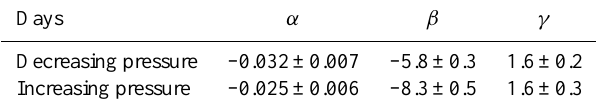
Table 4. Parameters obtained from ecosystem light response curves shown in Fig. 5. Where α (µmolCO 2 J − 1 ) is the canopy light utilization efficiency and represents the initial slope of